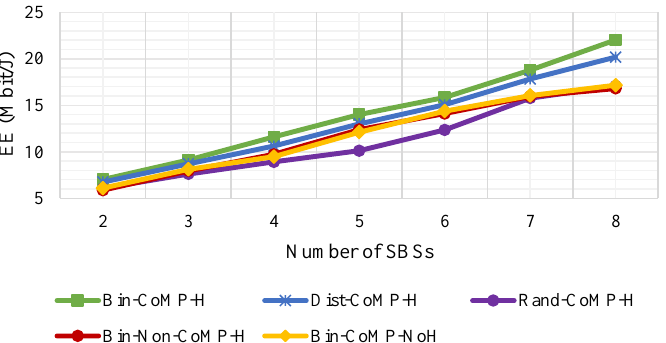
Figure 5. EE for various number of SBSs analysed for different BS-Sw methods and BS coordination = 10 dB and E HC = 2 techniques with E HC M S